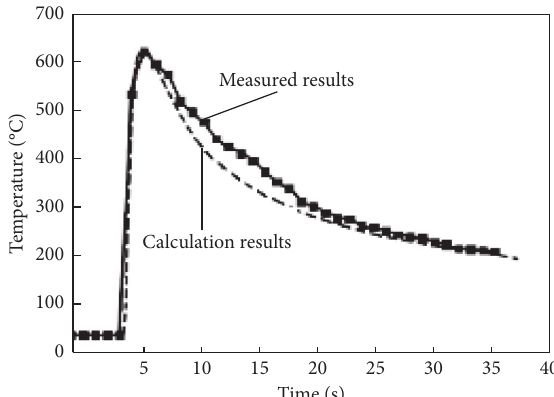
Figure 12: Comparison of measured and simulated results of lap joint